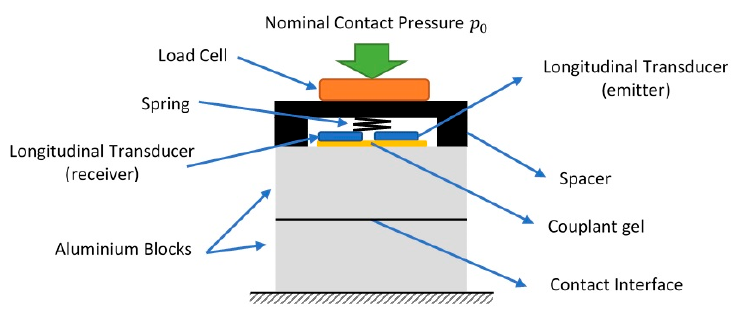
Figure 4. Schematic diagram of ultrasound reflection measuring apparatus.